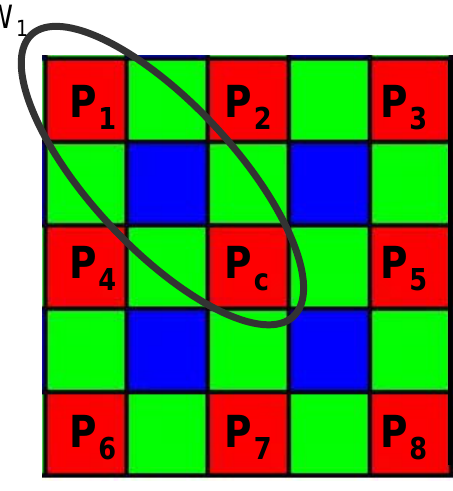
Figure 8. The Wi coefficients weight the similarity degree between the central pixel and its